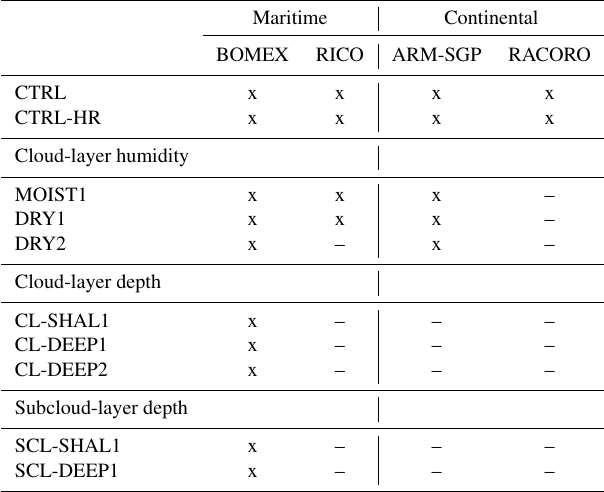
Table 2. Summary of numerical experiments. See text for further